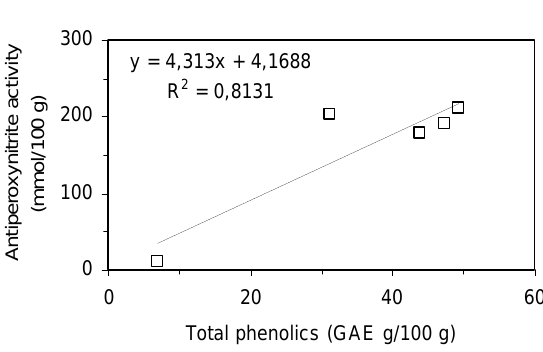
Figure 6 : Correlation of antiperoxynitrite and anti DPPH activity of extracts and of total phenolics